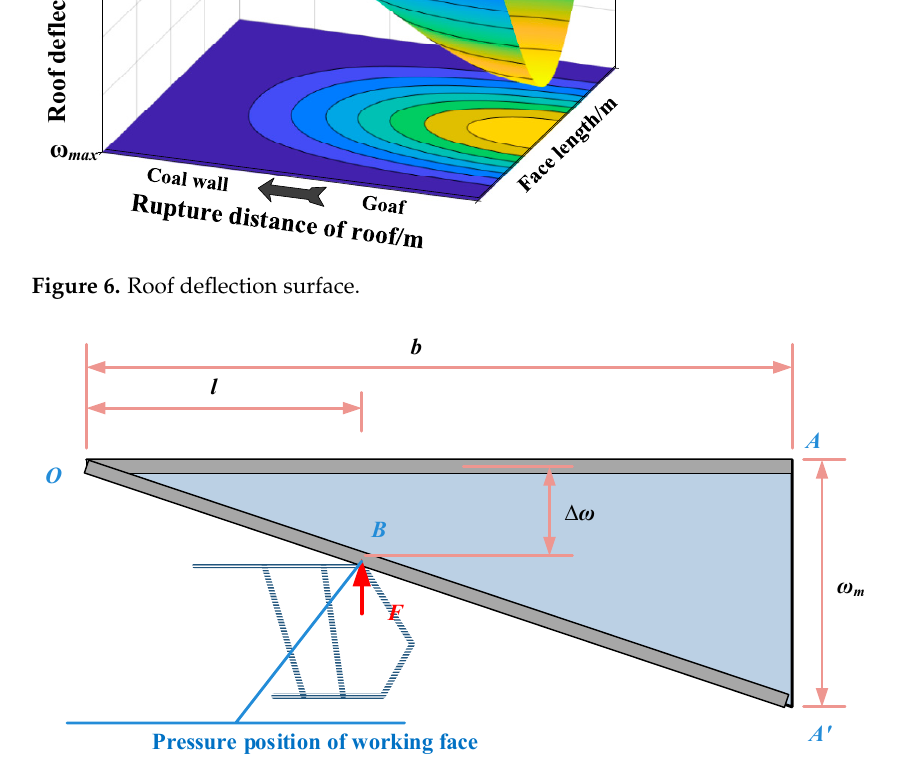
Figure 7. Main roof pressure sinking structure.